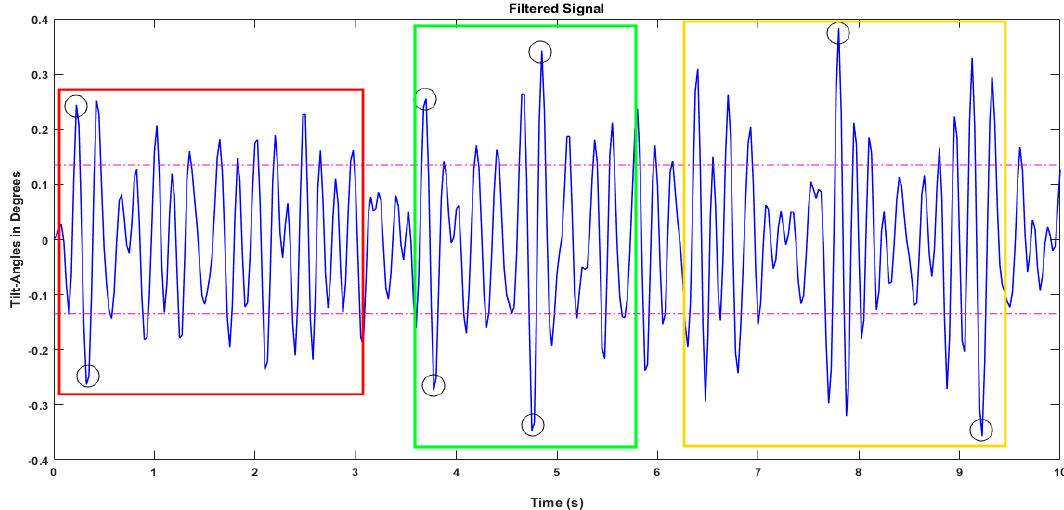
Figure 6. The runtime signal mean-clustering calculation.